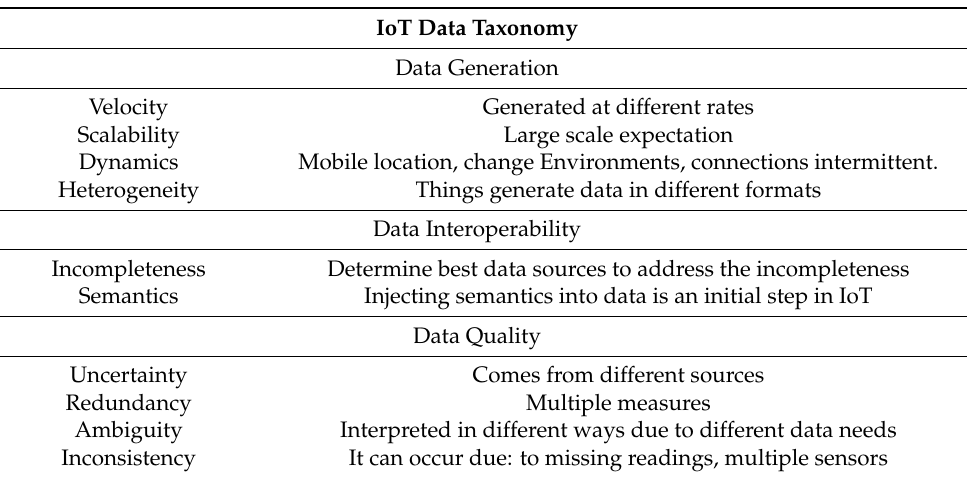
Table 1. IoT Data